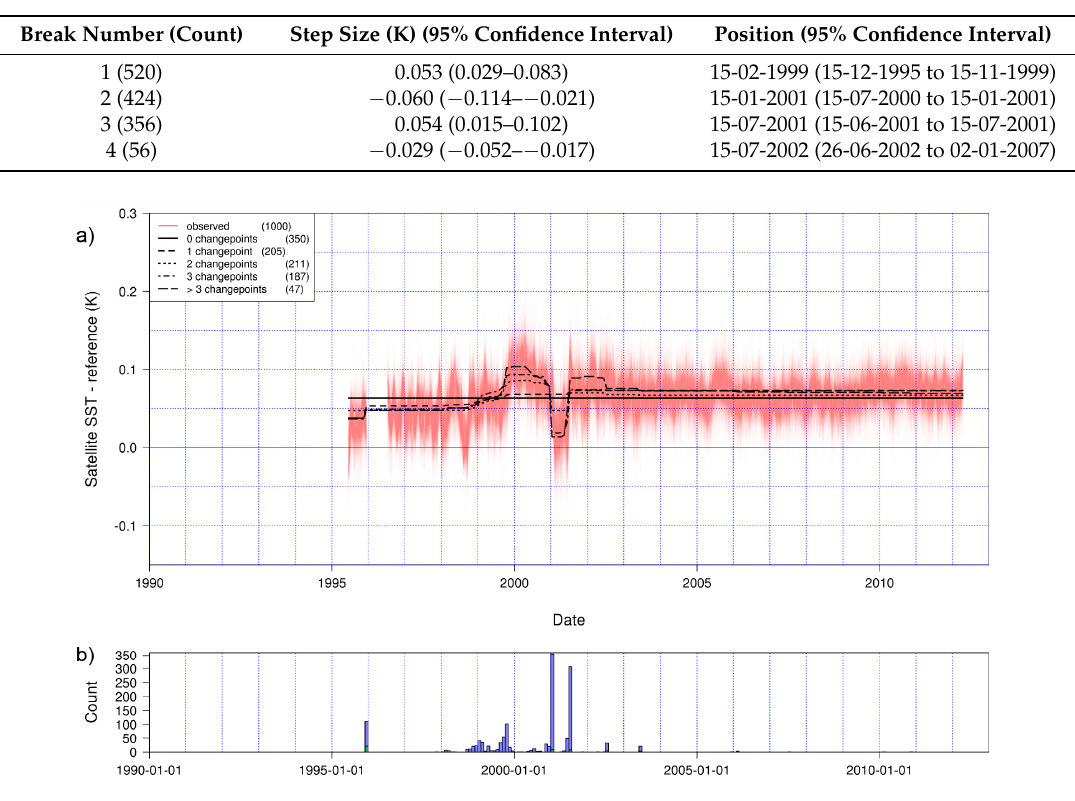
Figure 6. As Figure 3 but for drifting buoy observations. ( a ) The monthly mean differences (satellite in situ) for the individual ensemble members are shown in red. Also shown are the means of the model fitted by PMT grouped by number of change points detected. ( b ) Histogram of the data of the change points detected across all ensemble members.